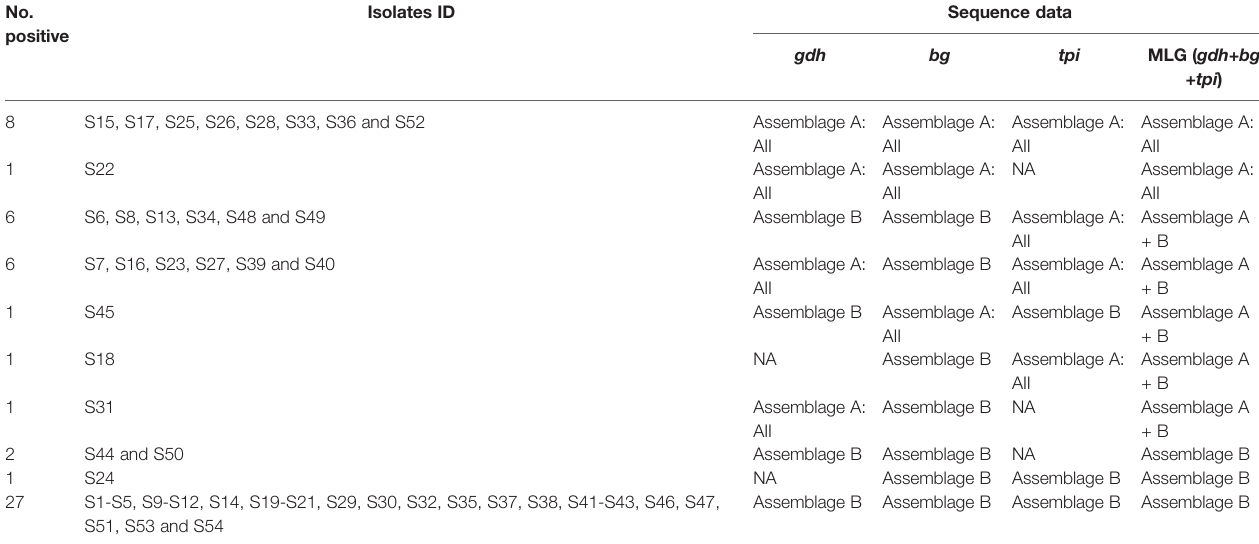
TABLE 2 | Assemblages and sub-assemblages of G. duodenalis isolates characterized by sequencing in this study. No.